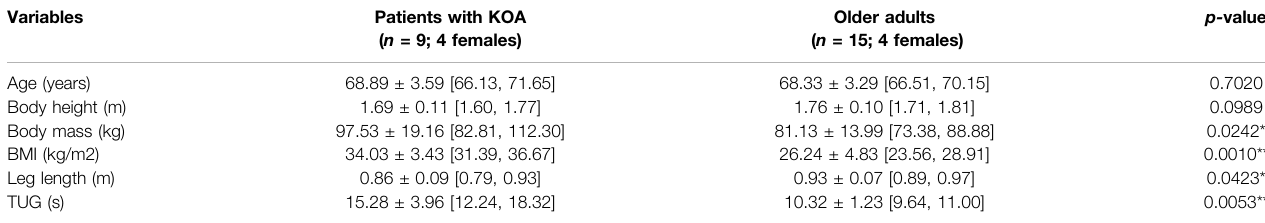
TABLE 1 | Basic information of patients with knee osteoarthritis (KOA) and older adults. Variables